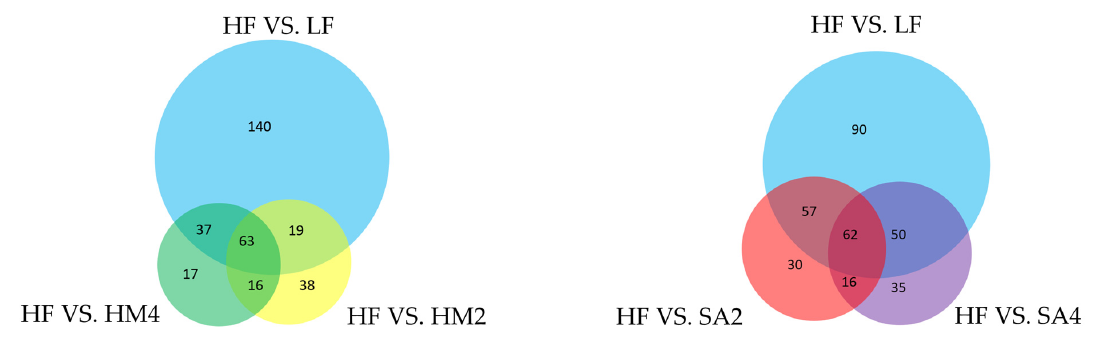
Figure 5. Each circle in the figure represents a comparison group, the numbers of circles and overlapping parts of the circle represent the number of differential metabolites common between the comparison groups, and the numbers without overlapping parts represent the number of differential metabolites specific to the comparison group.